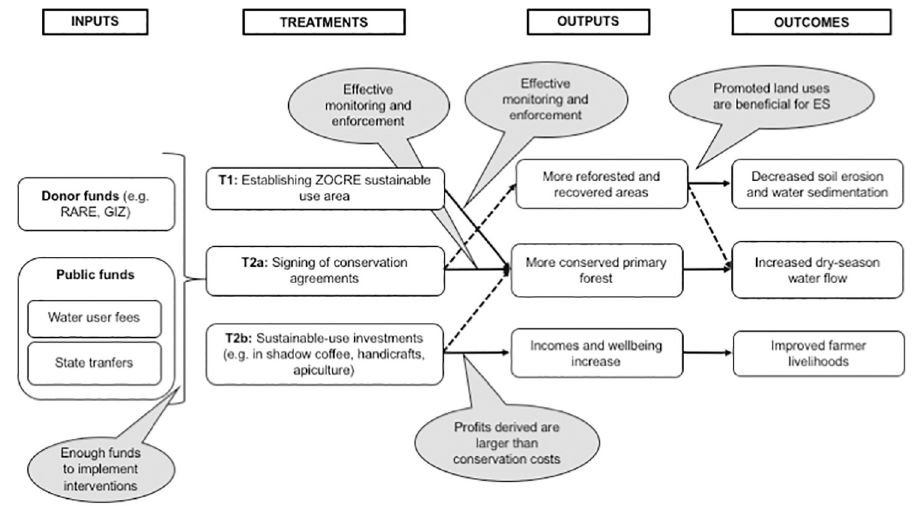
Fig 2. Theory of change for the Moyobamba watershed initiative. Source: own elaboration.